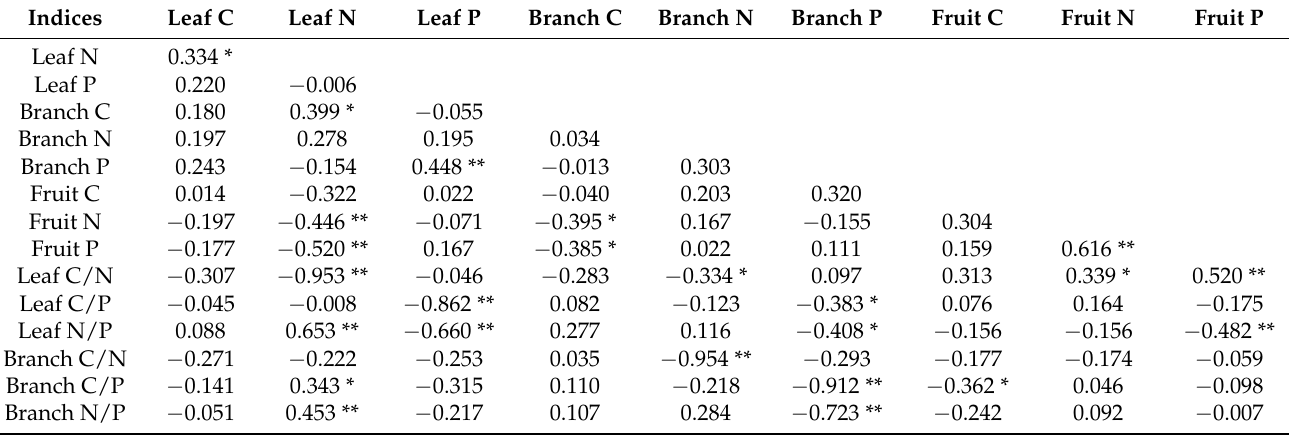
Table 2. The correlation of C, N and P contents and their ratios of different organs of female plants of F. velutina